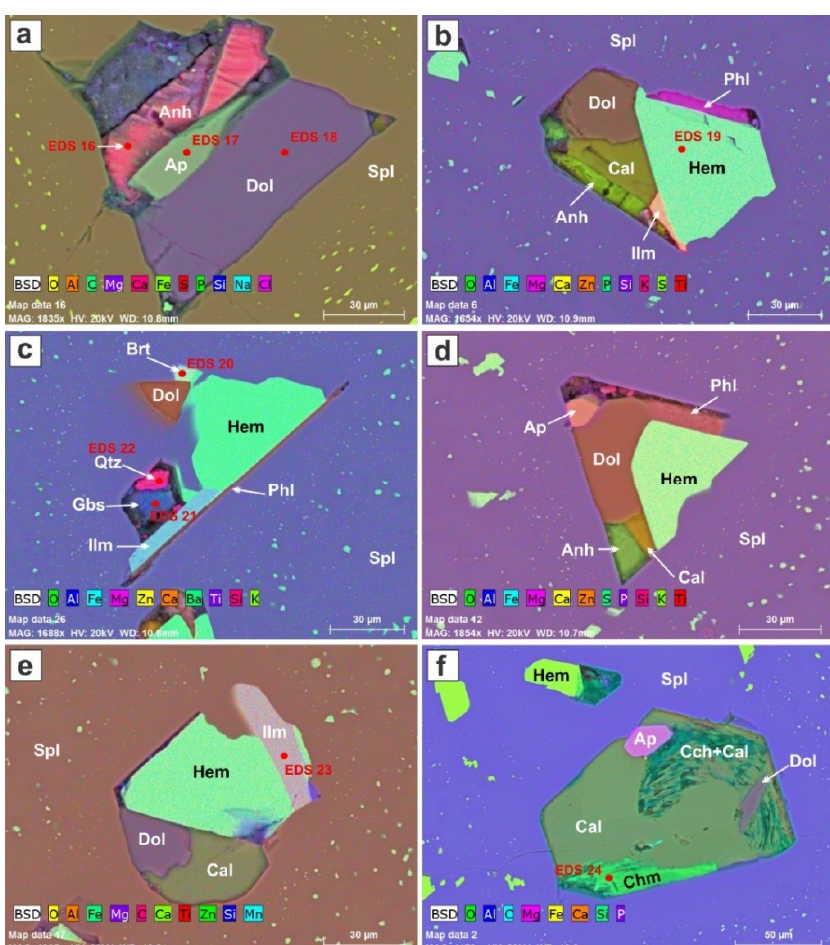
Figure 9. False-color EDS element-distribution maps of polymineralic micro-inclusions found in the two polished halves of the large single crystal of spinel. EDS point analyses 16 to 24 are shown in Figure S5. Symbols not yet defined: Anh: Anhydrite; Brt: Baryte; Chm: Chamosite; Qtz: Quartz.